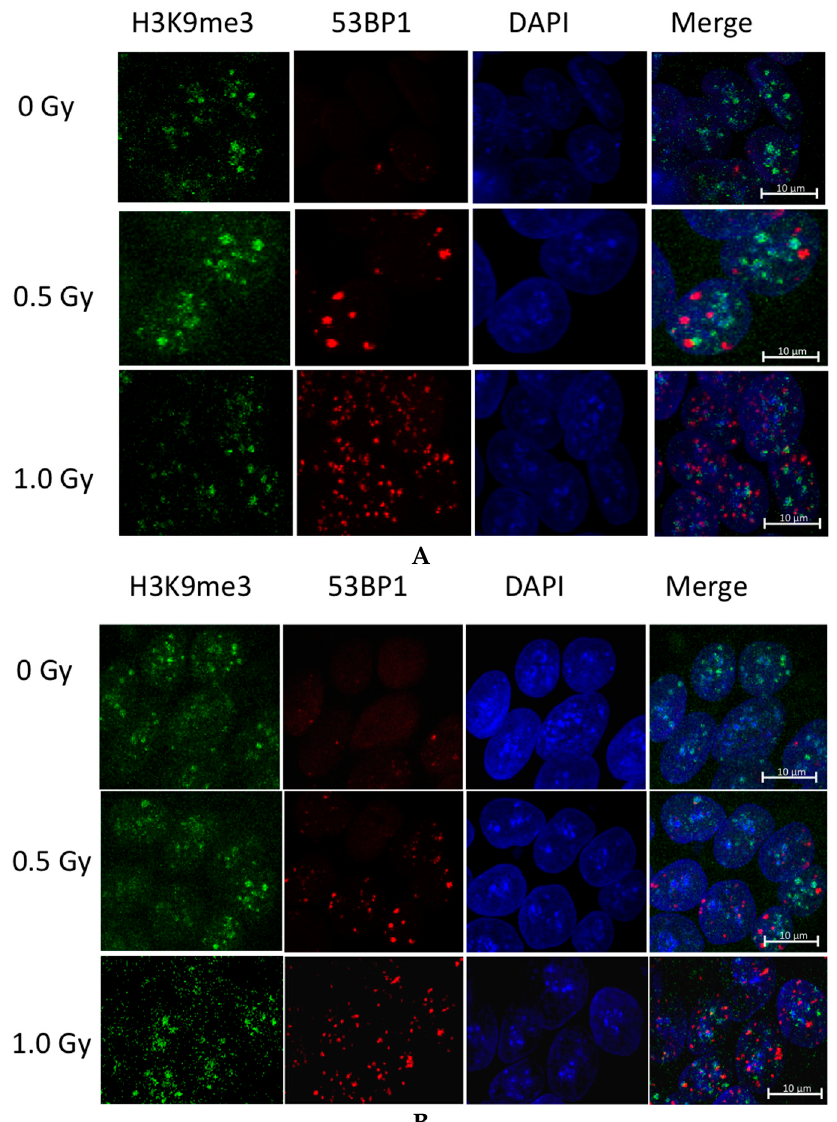
Figure 6. Co-staining for heterochromatin and RIF. Maximum intensity projection confocal microscopy images of ( A ) H9 and ( B ) H1 hESC staining for H3K9me3 ( green ); 53BP1 ( red ) and DAPI ( blue ). Majority of the RIF located outside heterochromatin regions.